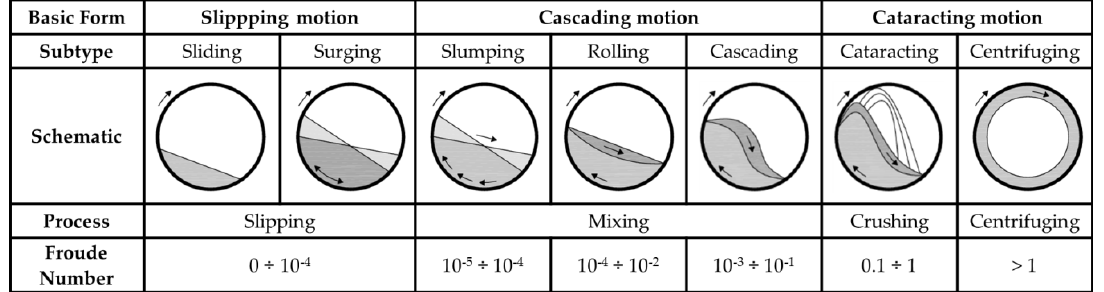
Figure 1. Types of material movements in the rotary drum [7].